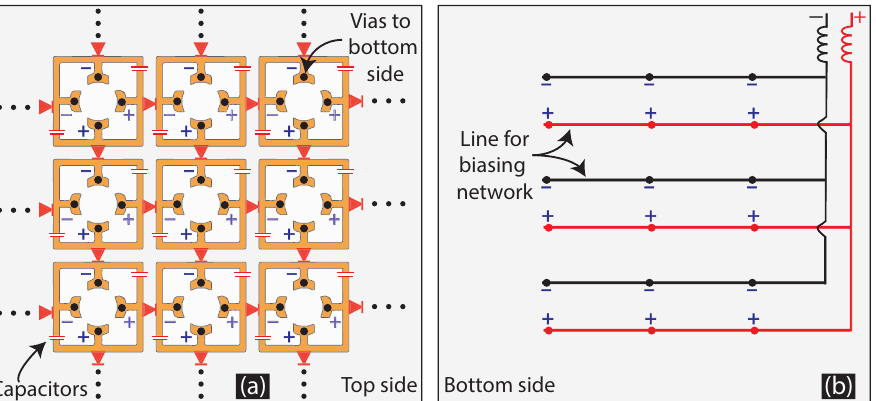
Figure 9. Biasing network topology for PIN diode switching; ( a ) PIN diodes’ locations and vias for connections and ( b ) the biasing network on the back side with RF